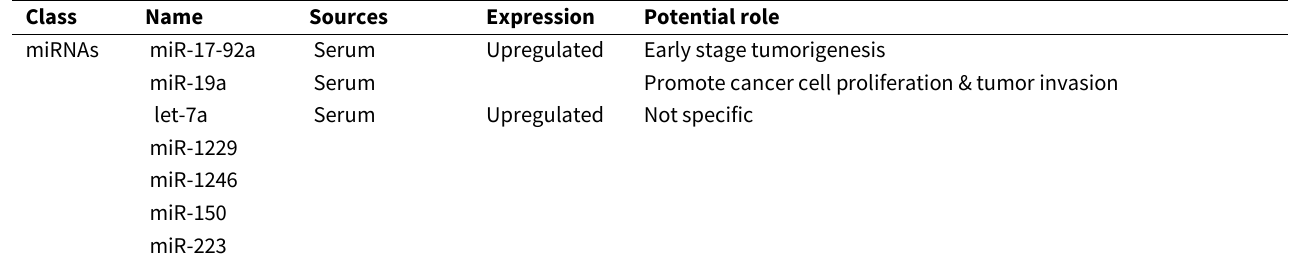
Table 1. Summary of Studies Showing Differences in Expression of Exosomes in CRC